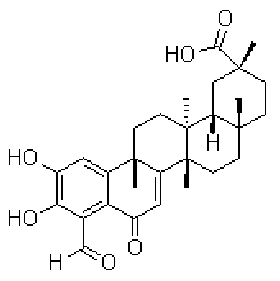
Figure 1. The structure of